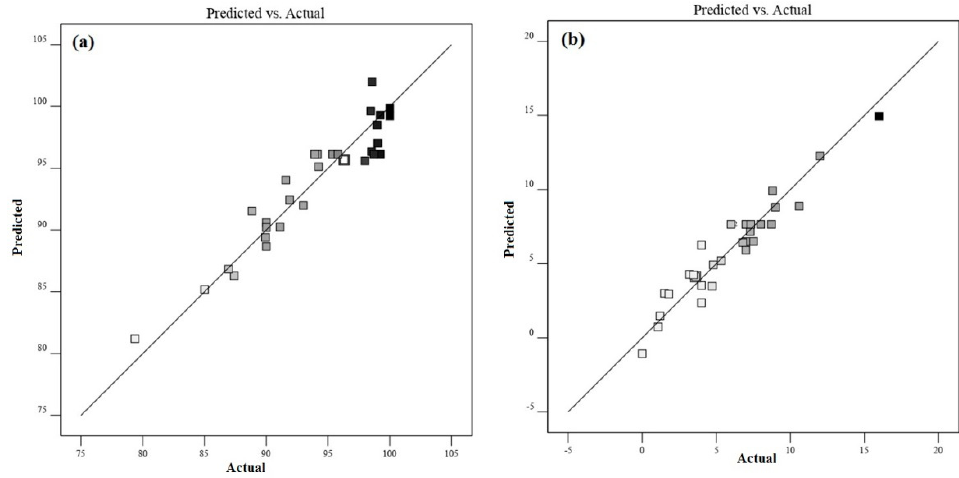
Figure 4. Predicted extracted percent versus actual extraction percent for ( a ) Se and ( b ) Te.